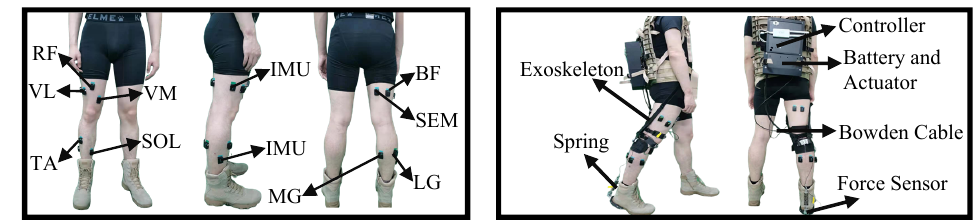
Figure 1. A sketch of the sensors setup and the exoskeleton